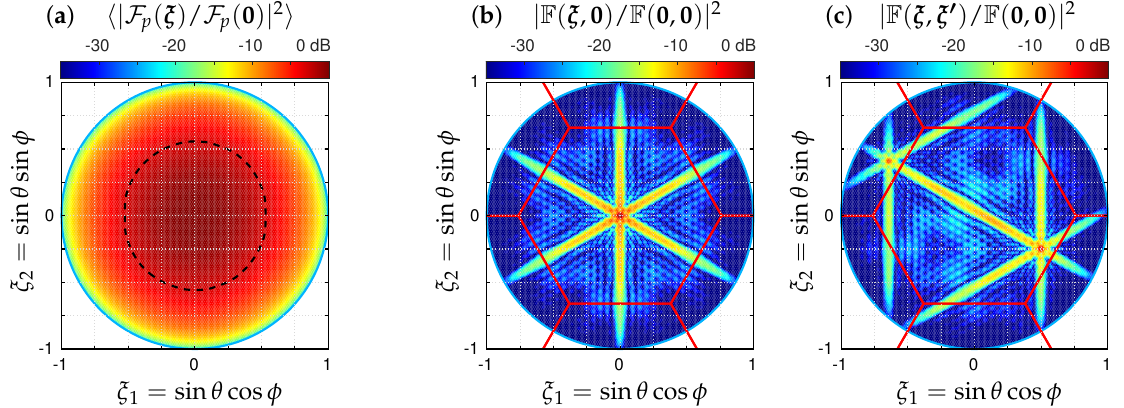
Figure 3. Comparison between ( a ) the average power pattern (cid:104)|F p ( ξ ) | 2 (cid:105) of the SMOS 69 elementary antennas and two examples of the array power pattern | F ( ξ , ξ (cid:48) ) | 2 of that Y-shaped array: ( b ) when the antenna array points into the boresight direction ξ (cid:48) = ( 0,0 ) and ( c ) when it points into the direction ξ (cid:48) = ( 0.5, − 0.25 ) . The main beam of (cid:104)|F p ( ξ ) | 2 (cid:105) is as wide as 1.135 rad (or 65 ◦ ), as emphasized by the dashed circle, whereas that of | F ( ξ , 0 ) | 2 is as narrow as 0.0355 rad (or 2 ◦ ). As a consequence of the attenuation caused by the element power patterns, the peak value in ( c ) is about − 3.2 dB below that in ( b ). The field of view of SMOS is subject to aliasing because of the spacing between the elementary antennas: the hexagonal synthesized field of view and its six neighbors are drawn in red, and its extension from side to side is equal to 1.32 rad, as illustrated in ( c ) by the angular Euclidian distance between the main beam in ( 0.5, − 0.25 ) and its alias in ( − 0.64,0.41 ) . For ease of comparison, power patterns are here normalized and the same color scale is